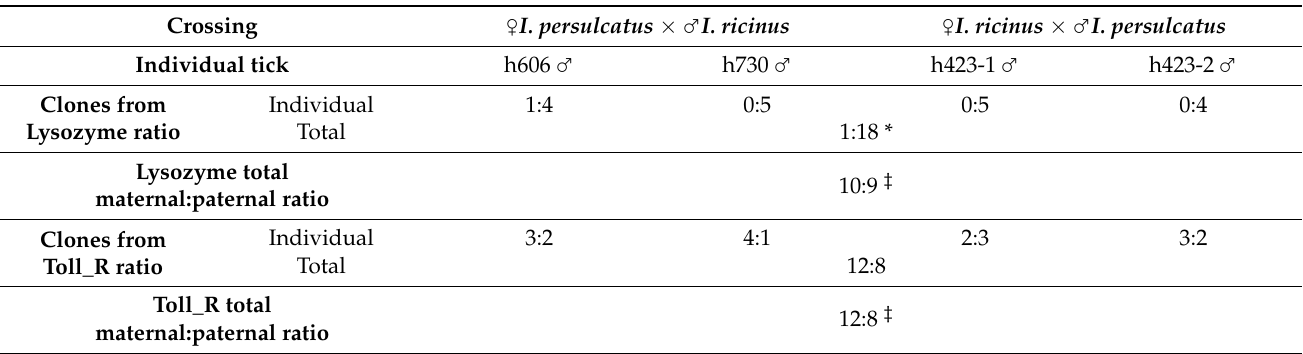
Table 6. Ratios of I. persulcatus : I. ricinus molecular clones of the lysozyme and Toll region obtained for hybrid ticks.